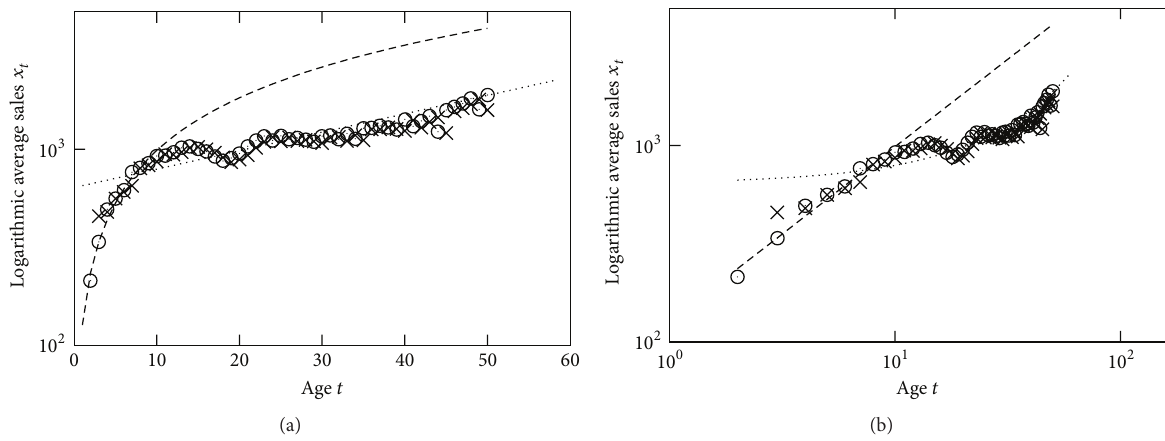
Figure 4: (a) By classifying sales of firms in 2007 in Japan included in ORBIS database into age-rank bins with 1-year width, logarithmic average of sales in each bin (𝑡 = 1,2,...,50) is depicted by circles in single logarithmic plots. Similarly, logarithmic average of sales in 2008 in Japan is also depicted by crosses. (b) Logarithmic average of sales 𝑥 𝑡 classified into age-rank bins with a 1-year width is plotted in double logarithmic plots. In both figures, dashed and dotted lines represent optimal power-law and optimal exponential functions,